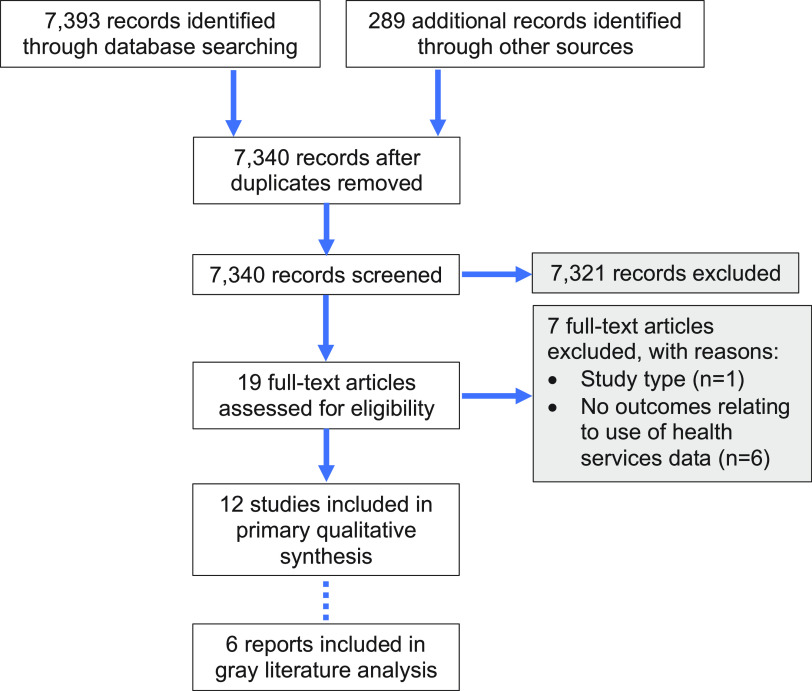
Screening Process Used for Systematic Literature Review of Evidence on Use of Health Service Delivery Data at the Primary Care Level in Low- and Middle-Income Countries